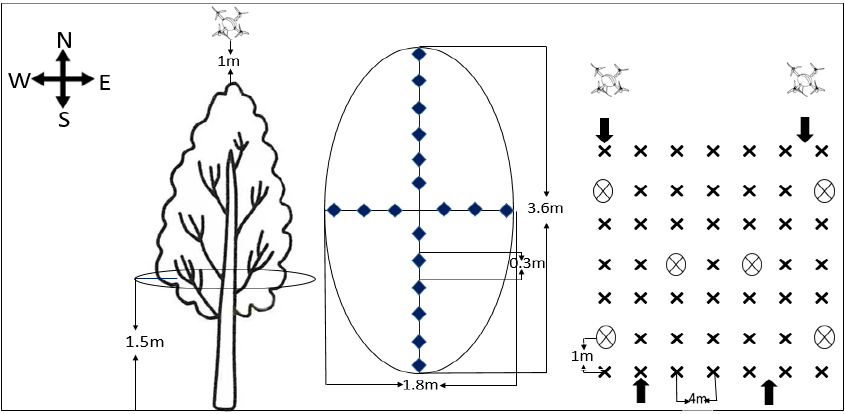
Figure 1. Schematic diagram of the water-sensitive paper sampling points and UAV flight path.